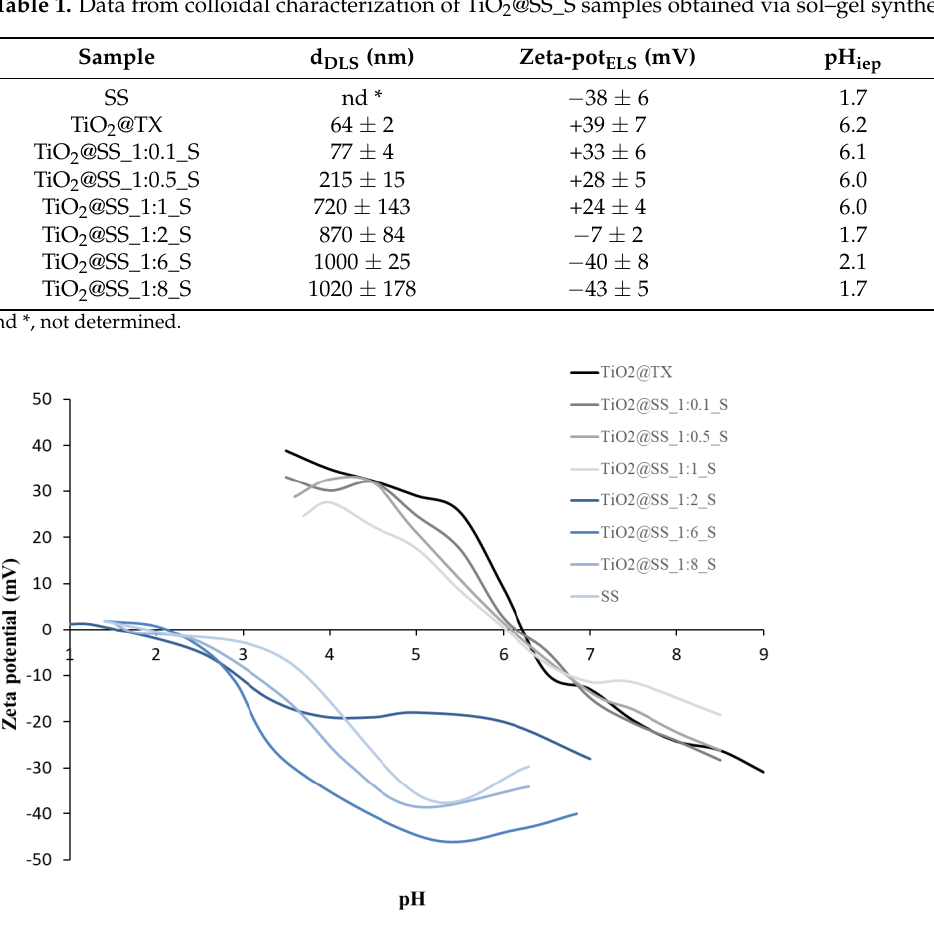
Figure 1. Zeta potential as a function of pH curves for TiO 2 @SS_S samples obtained via sol – gel syn-